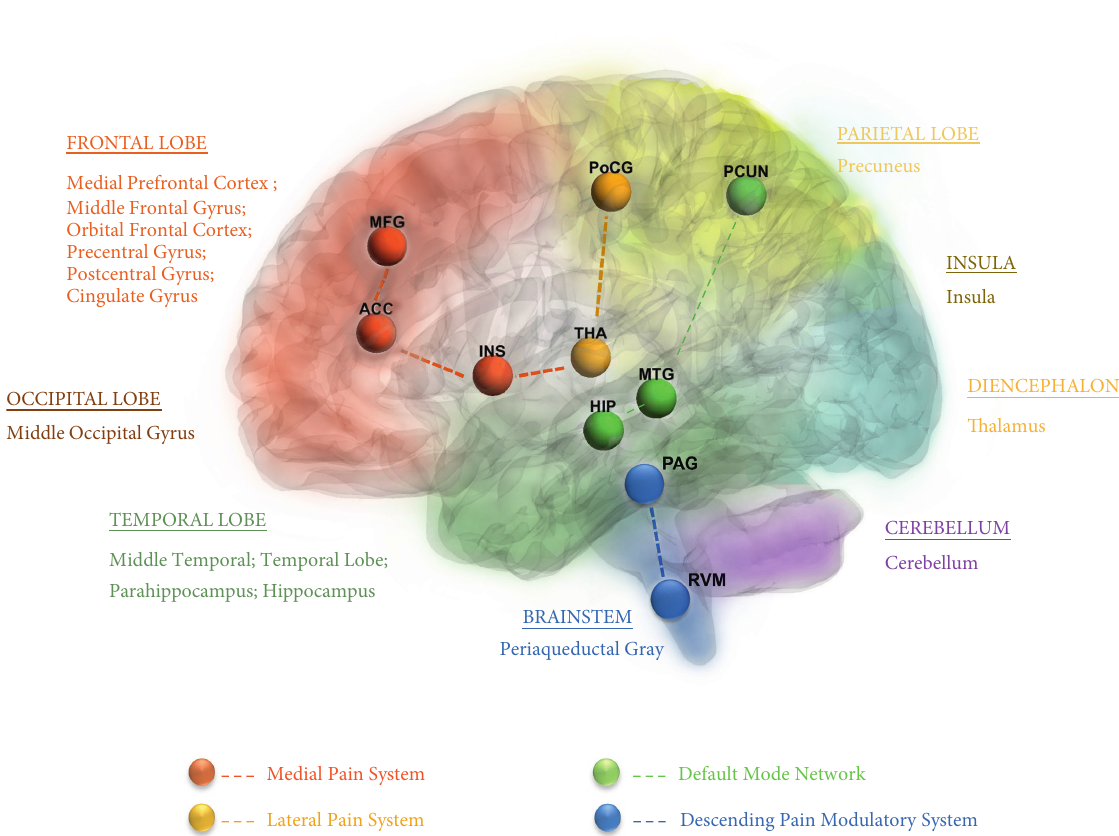
Figure 2: The main findings of acupuncture for migraine by neuroimaging techniques. The different shadow colors represent the different functional classifications of the brain. The high frequent reported areas that have been affected by acupuncture for migraine in the included studies were noted with different colors. The different color nodes represent the different pathways or networks. ACC, anterior cingulate cortex; DMN, default mode network; HIP, hippocampus; INS, insula; MFG, middle frontal gyrus; MTG, medial temporal gyrus; PAG, periaqueductal gray; PCUN, precuneus; PoCG, postcentral gyrus; RVM, rostral ventromedial